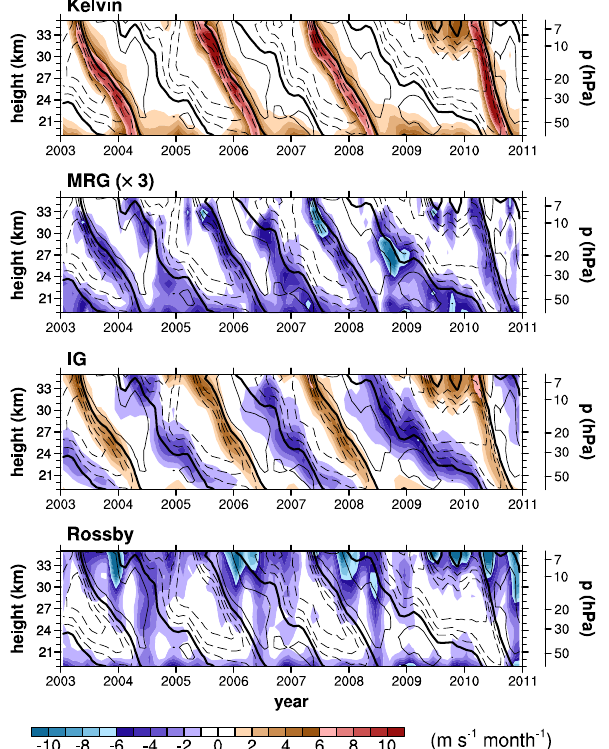
Figure 1. Time–height cross sections of the zonal momentum forc- ing by the Kelvin, MRG, IG, and Rossby waves (from top to bot- tom) averaged over 5 ◦ N–5 ◦ S, obtained using the model-level data of ERA-I over the period 2003–2010 (shading). The MRG wave forcing is multiplied by 3. The zonal mean wind over 5 ◦ N–5 ◦ S is superimposed at intervals of 10ms − 1 (contour). The thin solid, dashed, and thick solid lines indicate westerly, easterly, and zero wind,